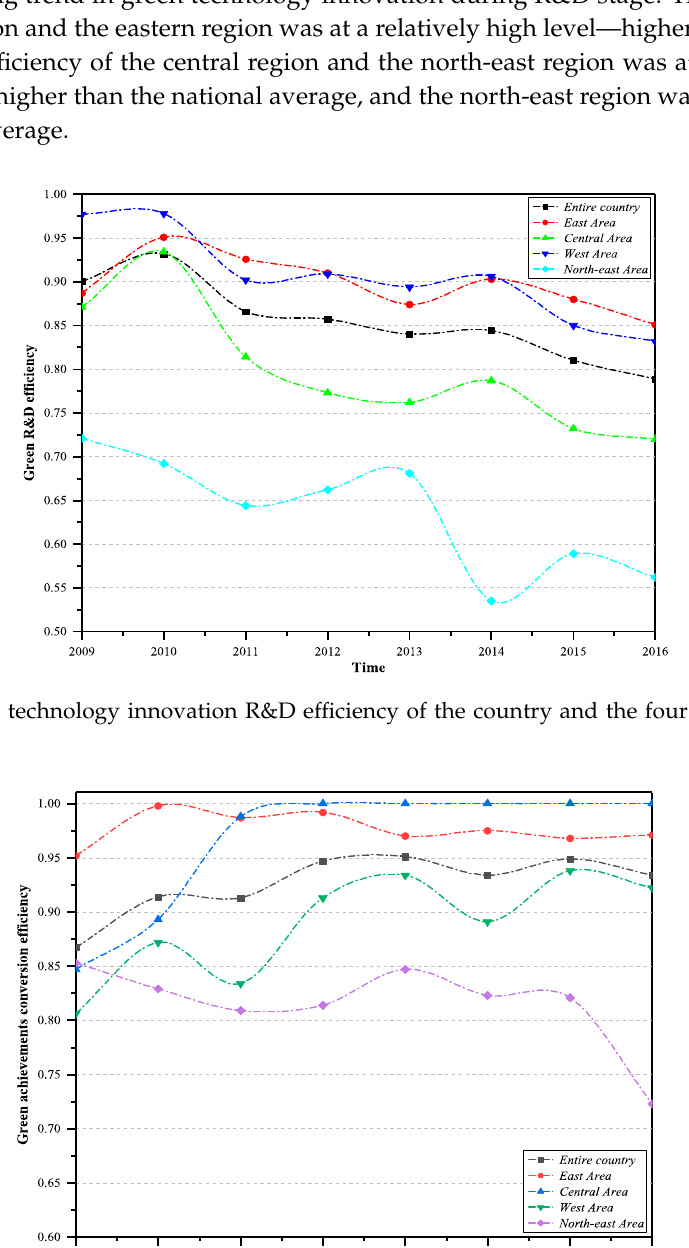
Figure 5. Green technology innovation comprehensive efficiency of the country and the four major regions (2009 – 2016).